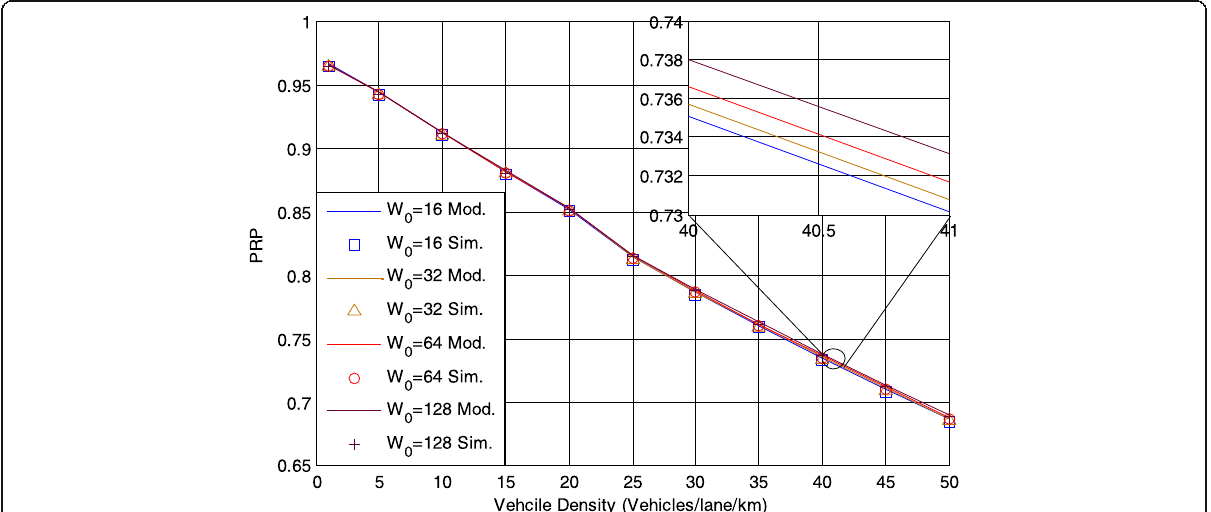
Fig. 11 Comparison of the analytic model and simulation results of PRP with hidden terminal collisions for various minimum contention window